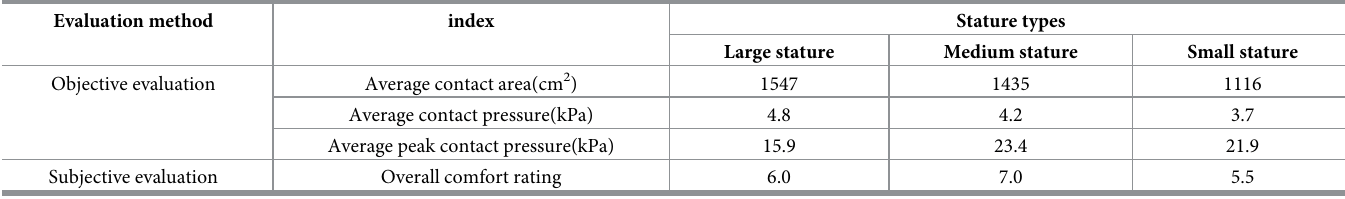
Table 7. Subjective and objective evaluation index value on